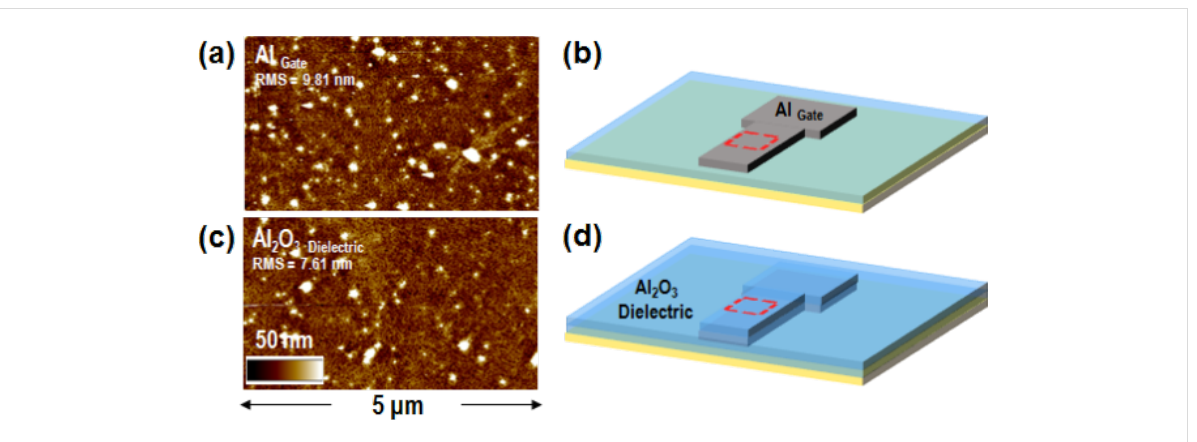
Figure 3: a) Tapping mode atomic force microscopy (tAFM) morphology and b) schematic illustration of the aluminum back-gate pad. c) tAFM mor- phology and d) related schematic illustration of the Al 2 O 3 deposited by the low temperature ALD